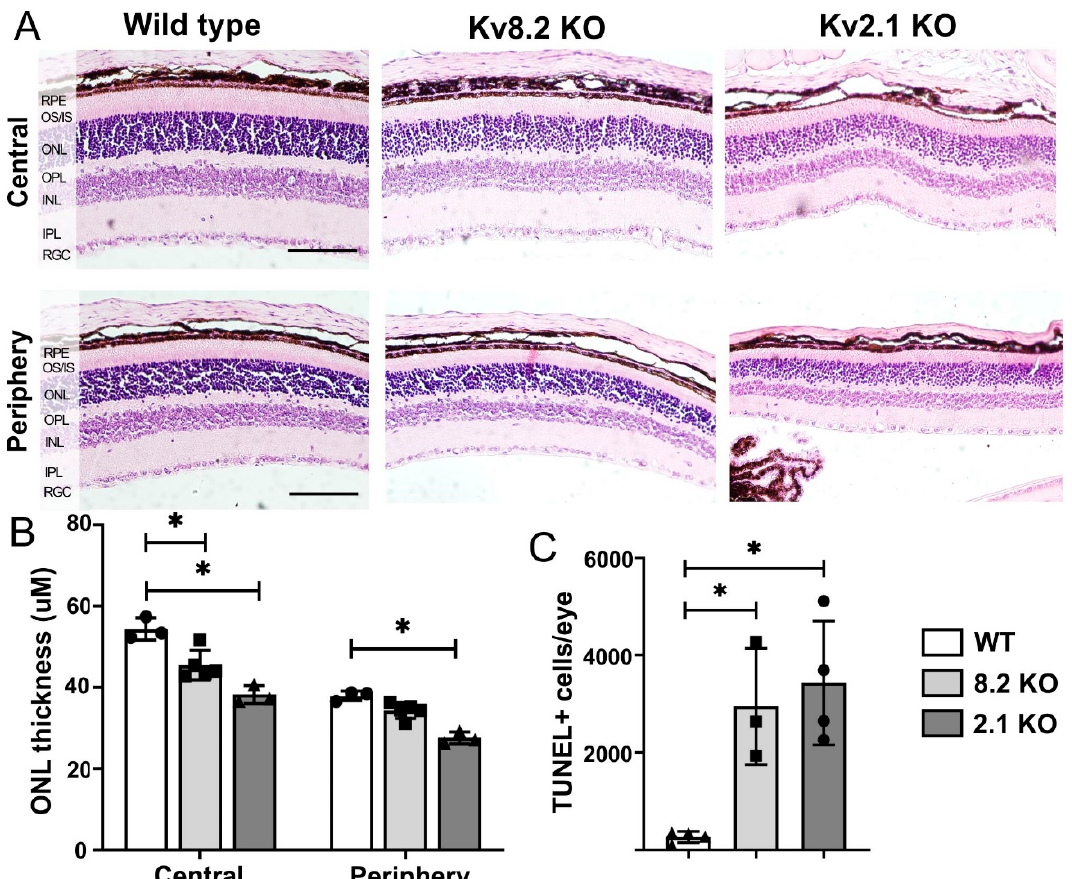
Figure 3. Retinal thickness and cell death in wild type (WT) and knockout (KO) retinas. ( A ) Representative histological retinal sections from the dorsal-ventral region of KO models and WT showing the different retinal layers. RPE, retinal pigment epithelium; OS/IS, outer segment/inner segment; ONL, outer nuclear layer; OPL, outer plexiform layer; INL, inner nuclear layer; IPL, inner plexiform layer; RGC, retinal ganglion cells. Scale bar = 100 μ M. ( B ) Quantification of outer nuclear layer (ONL) thickness in the different mouse models in central (10° from optic nerve) and peripheral (80° from optic nerve) areas of the retina. No differences were observed between dorsal or ventral areas. The results are presented as mean +/ − SEM, with statistical analysis by two-way ANOVA and Sidak’s multiple comparison test post hoc with * p < 0.002. ( C ) Quantification of cell death in the ONL of WT, Kv8.2 KO and Kv2.1 KO retinas via TUNEL (Terminal deoxynucleotidyl transferase dUTP Nick End Labeling) staining. Results are presented as mean +/ − SD from n = 3–5, and p values were obtained through one-way ANOVA and Tukey’s multiple comparison test post hoc with * p < 0.006.